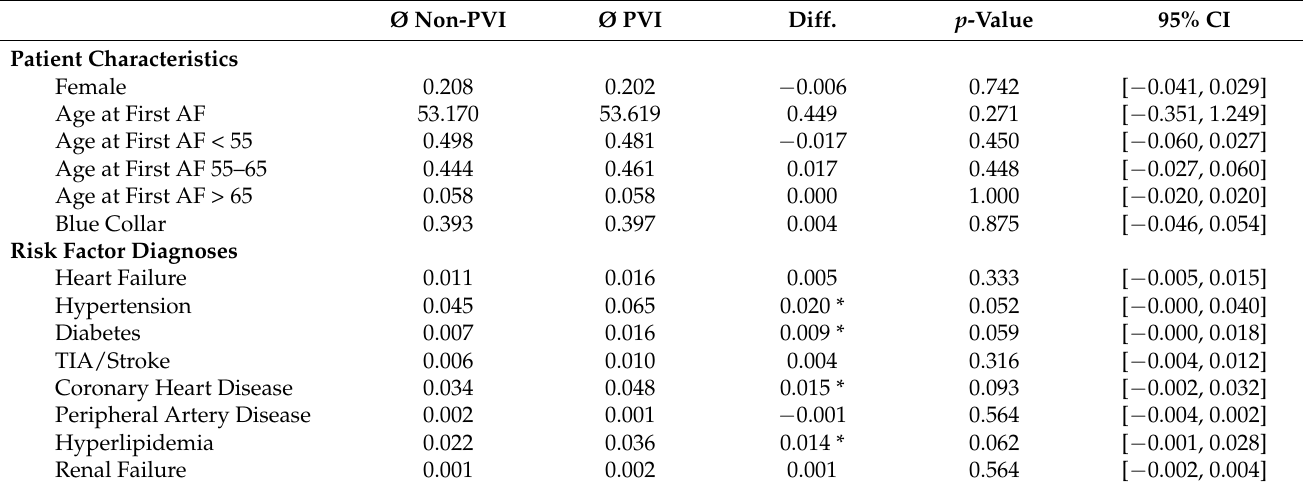
Table 1. Patient characteristics and risk factors used for propensity score